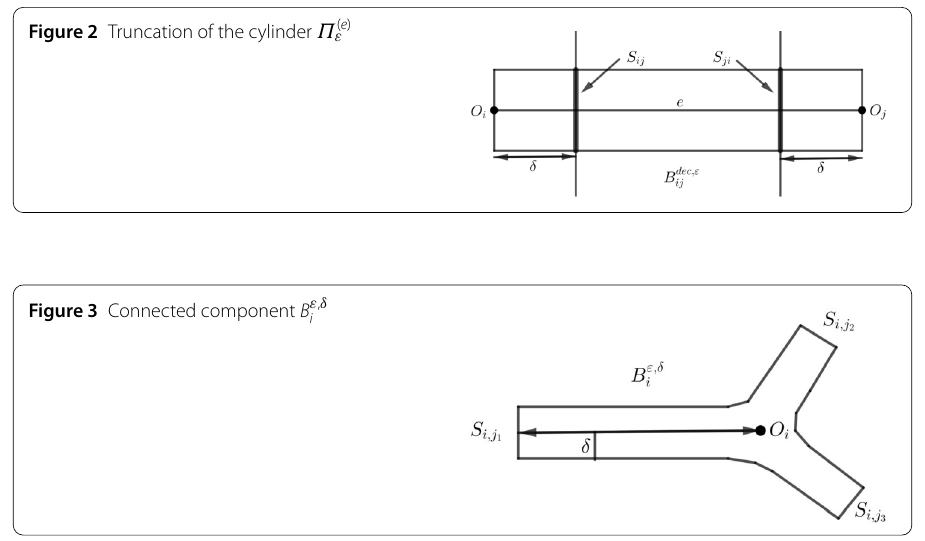
Figure 2 Truncation of the cylinder Π ( e ) ε